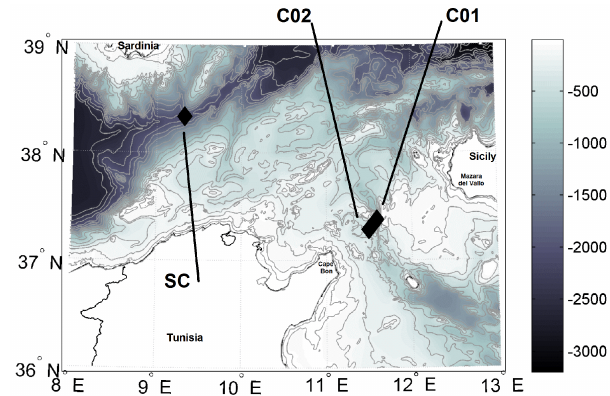
Fig. 7. Location of the three monitoring sites in the central Mediter- ranean (SC=Sardinia Channel; C01=mooring #1 in the Sicily Channel; C02=mooring #2 in the Sicily